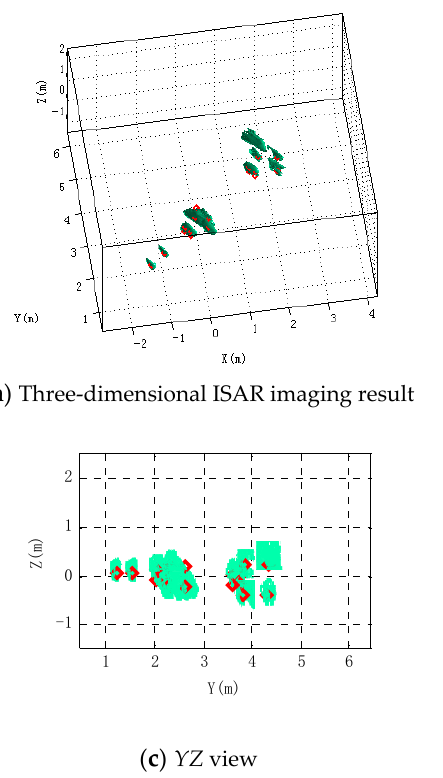
Figure 13. Imaging results when SNR = 15 dB.